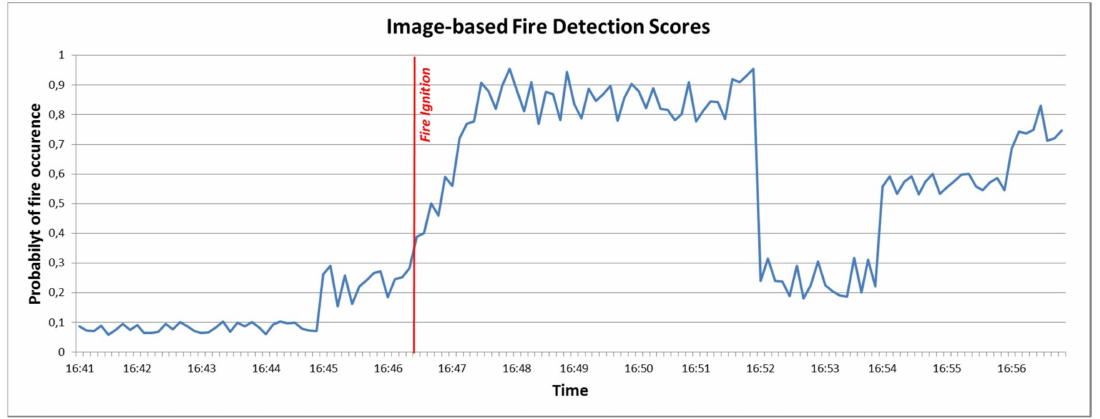
Figure 18. Image-based fire detection scores for the Mati-Rafina fire incident on 23/7/2018 over a 17 min interval before and after the actual fire ignition.